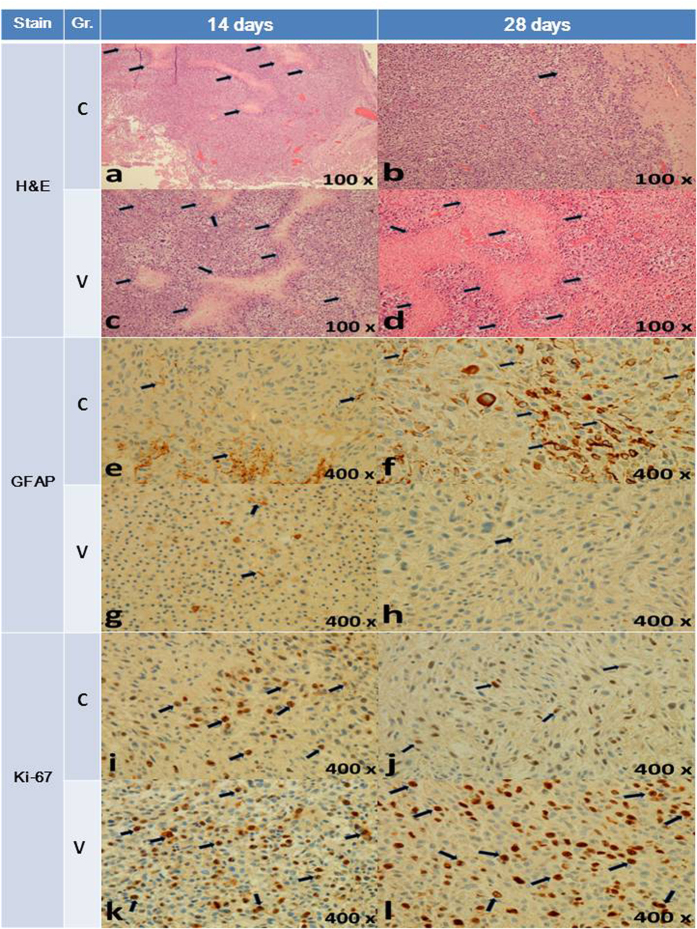
The black arrows indicate the central necrotic area (a–d), GFAP expression (e–h), and Ki-67-positive cells (i–l). The central necrotic area decreased in the concurrent group (a→b), whereas it increased in the vehicle-treated group (c→d). In the concurrent group, GFAP expression was suppressed at 14 days (e,f), and obvious GFAP expression was observed at 28 days (f). The Ki-67 index is 14.02% in (i), 8.92% in (j), 21.54% in (k), and 31.95% in (l). Gr.: group; C: concurrent group; V: vehicle-treated group; H&E: hematoxylin and eosin; GFAP: glial fibrillary acidic protein.